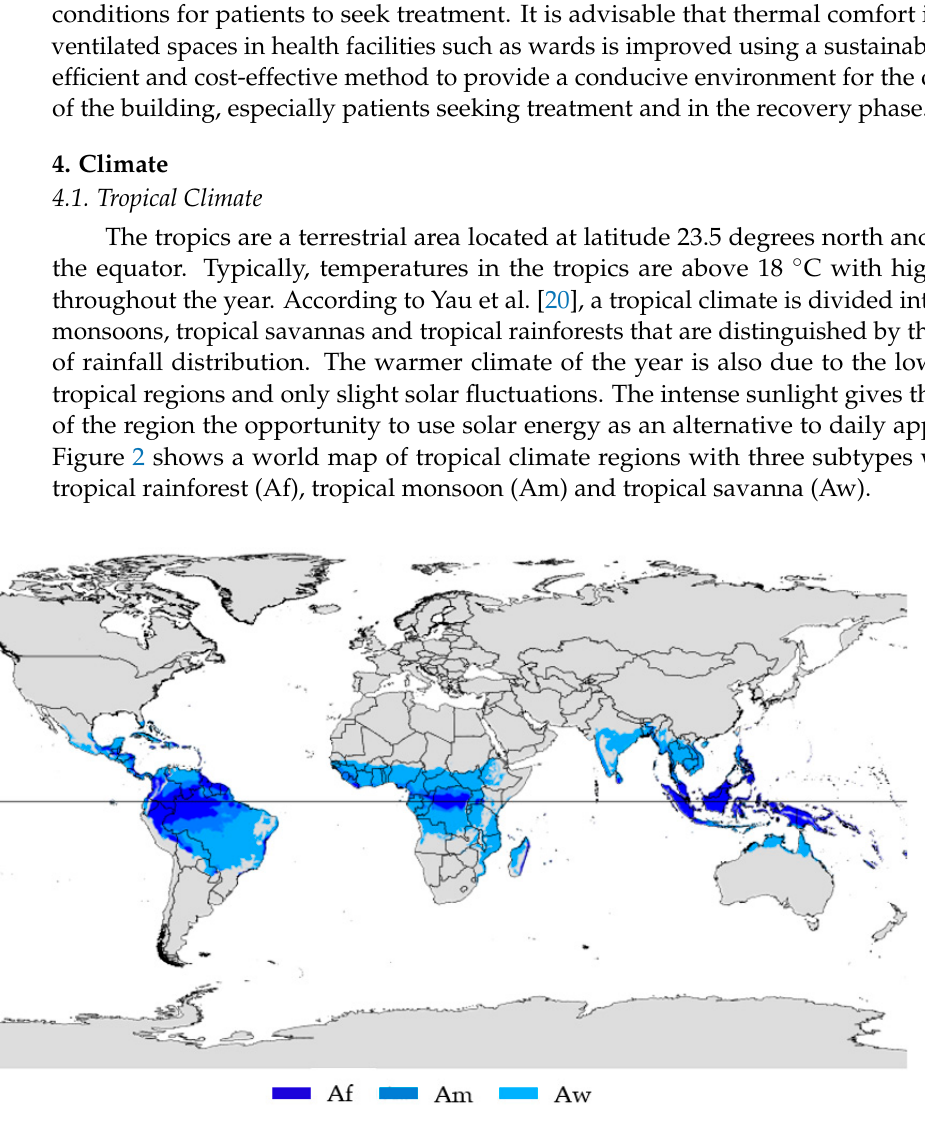
Figure 2. Tropical climate region [29].